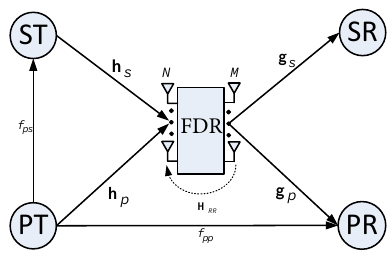
Figure 1. A cognitive radio network with a full-duplex relay